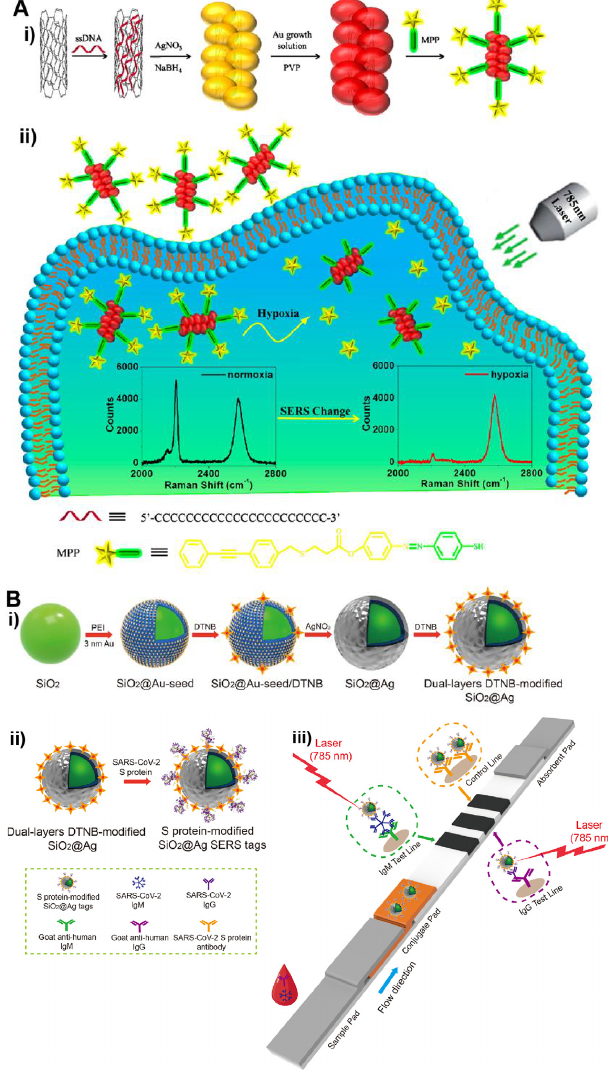
Figure 6. SERS active NM NPs-based POC tests. ( A ) SWCNT/Ag/AuNPs conjugates for SERS imaging of hypoxia: (i) preparation of the SWCNT/Ag/AuNPs conjugate-based SERS nanoprobe; (ii) sensing principle of hypoxia. Adapted with permission from ref [76]. Copyright 2019 American Chemical Society. ( B ) SERS-based LFA for detection of anti-SARS-CoV-2 IgM and IgG: (i) preparation of the dual-layers DTNB-modified SiO 2 @Ag NPs. DTNB = 5,5’-dithiobis-(2-nitrobenzoic acid); (ii) SARS-CoV-2 S protein-modified SiO 2 @Ag SERS tags; (iii) detection principle of the SERS-based LFA of anti-SARS-CoV-2 IgM and IgG. Adapted with permission from ref [77]. Copyright 2021 Elsevier B.V.